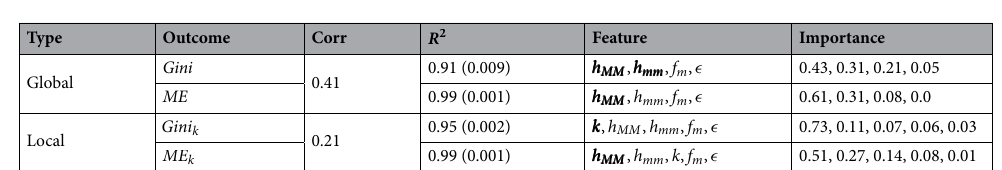
Table 1. Ten-fold cross-validation for PageRank. We use a Random Forest Regressor to assess feature importance and report the mean and standard deviation of the out-of-sample R descending order based on their mean importance (from left to right) and highlighted if their importance represents at least 50% of the total importance. Corr shows the Spearman correlation between inequality and inequity scores ( p -values ≈ 0 ). ǫ represents random